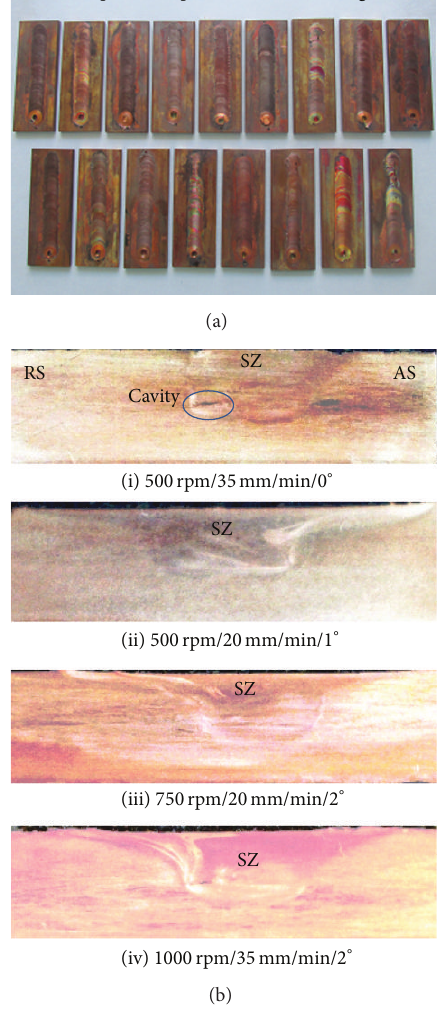
Figure 3: (a) Fabricated Cu/SiCp surface nanocomposites and (b) macrostructure of fabricated nanocomposites at different process parameter